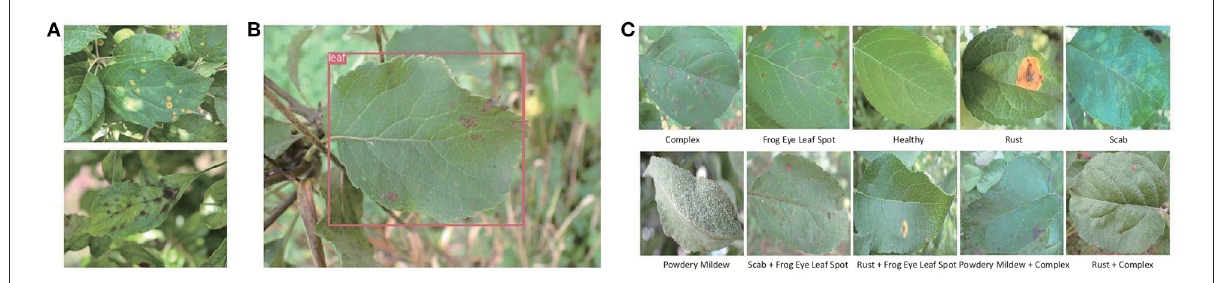
FIGURE1 (A) The original samples of AFD. (B) The leaf detection result by YOLO-v3. (C) The samples of 10 classes after segmentation and resizing.